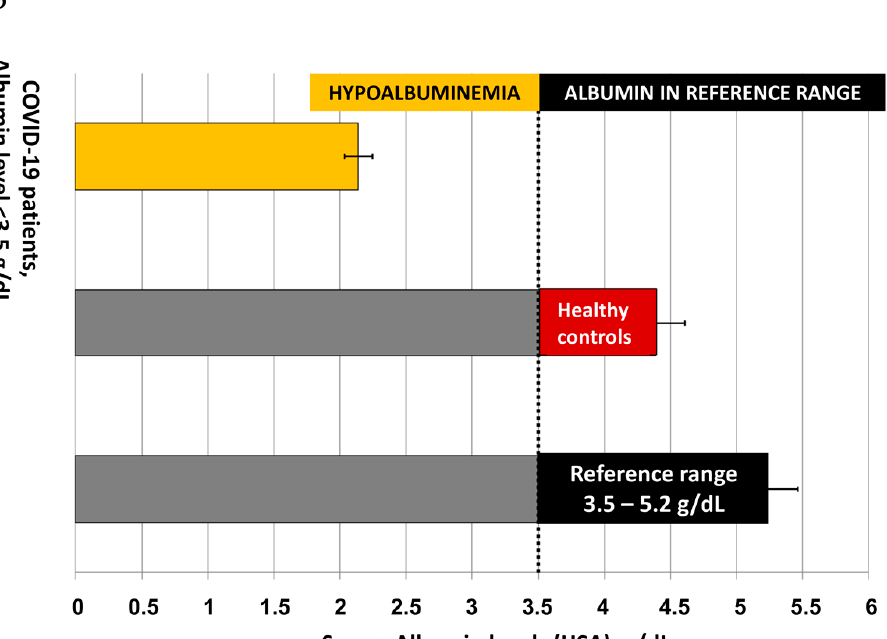
( A ) ( B ) Figure 2. Graphical representation of changes in serum albumin levels in patients with COVID-19 by gender (( A )—females, ( B )—males) measured from the time of admission.